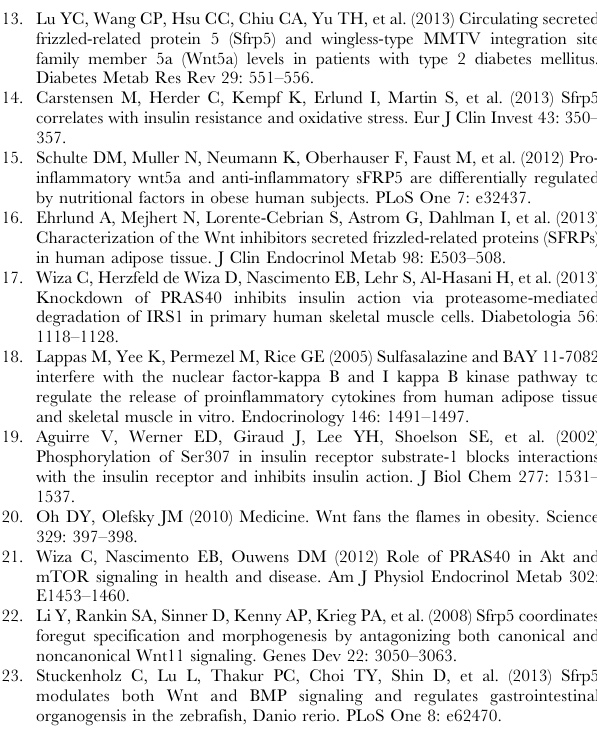
human skeletal muscle cells were exposed to Sfrp5 with ( + ) or without ( 2 ) Wnt5a (10 ng/ml) for 24 h. Cytokine release by the myotubes was quantified by ELISA, and expressed as mean 6 standard error of the mean (n= 4). Figure S2 Effect of Wnt5a and Sfrp5 on insulin signaling in primary human skeletal muscle cells. Primary human skeletal muscle cells were exposed to Sfrp5 with ( + ) or without ( 2 ) Wnt5a (10 ng/ml) for 24 h. Then, when indicated ( + ) cells were stimulated with insulin (10 min; 100 nM). Cell lysates were analyzed for phosphorylation of Akt-Thr308 (A), Akt-Ser473 (B), GSK3 a -Ser21 (C), and PRAS40-Thr246 (D) by Western blotting. Phosphorylation signals were normalized for GAPDH protein abundance and expressed as mean 6 standard error of the mean of five independent experiments using cells from different donors. The values obtained for untreated insulin-treated cells were considered as control and set at 100%. Differences among groups were calculated by two-way ANOVA followed by Bonferroni multiple comparison analysis. # , indicates p , 0.05 for the effect of insulin